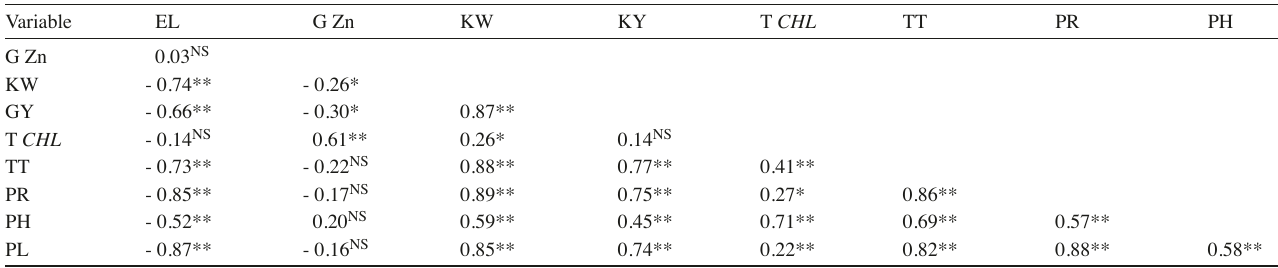
Tab. 6: Correlation matrix of agronomic, physiological and biochemical attributes of rice genotypes influenced by different Zn application methods (Means of both years used in the analysis) Variable